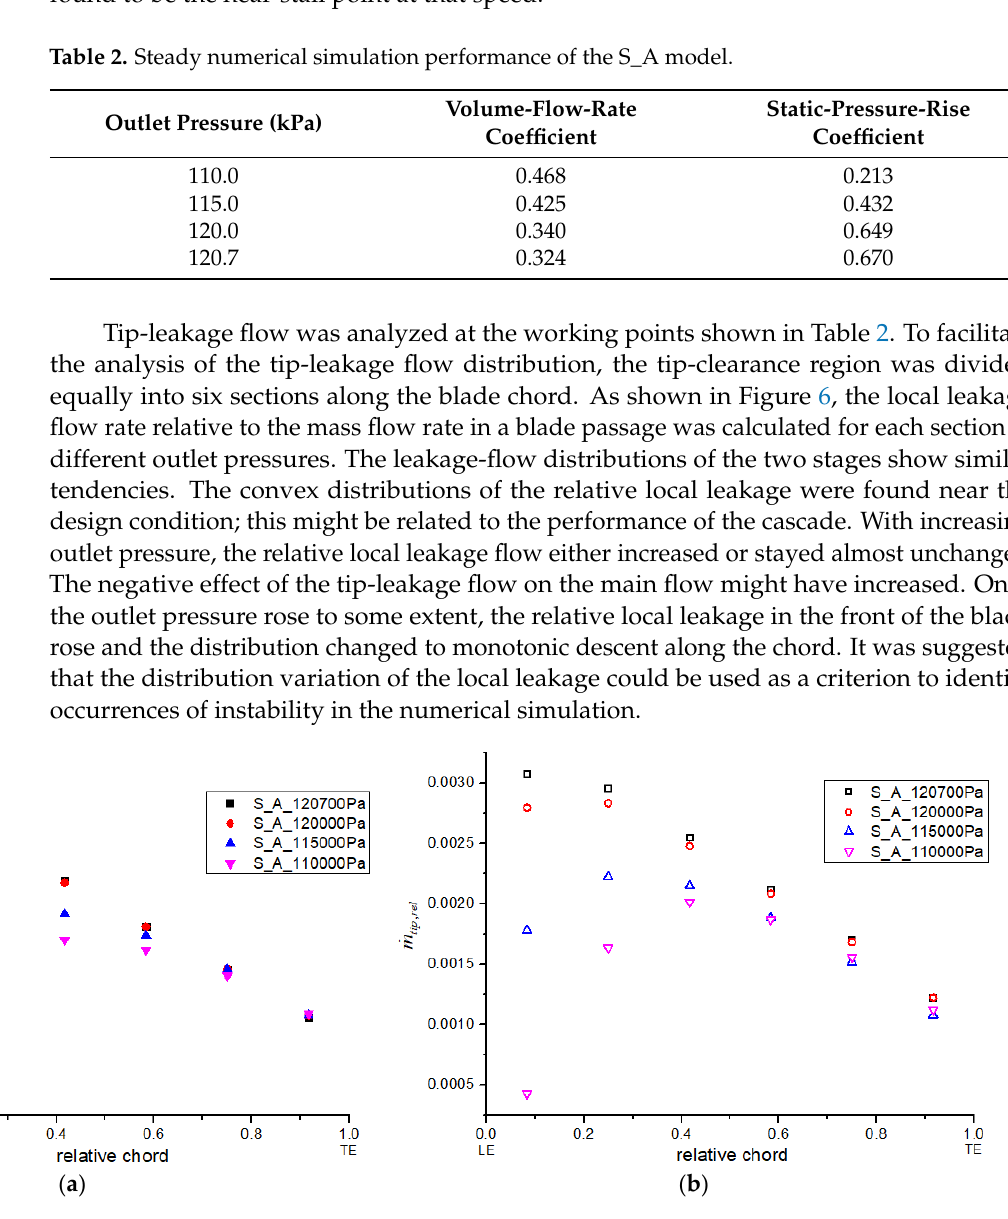
Figure 6. Relative leakage-flow distribution in S_A modal at 6000 rpm. ( a ) Local leakage flow in R1 and ( b ) local leakage flow in R2.